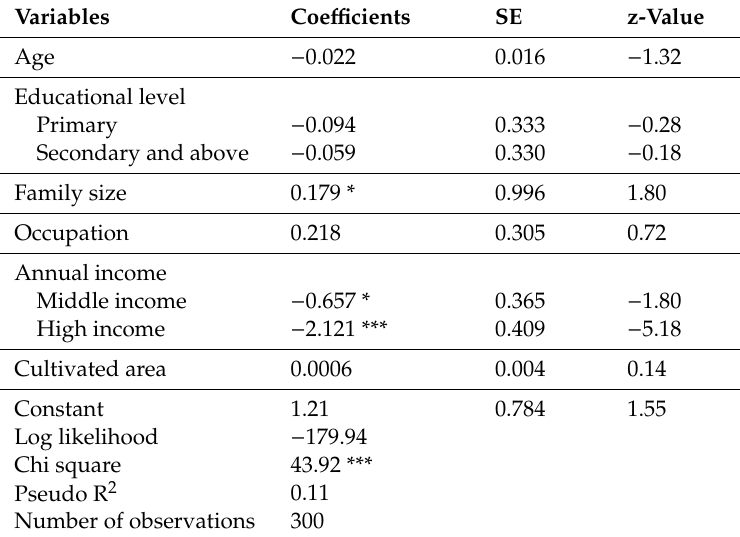
Table 5. Factors a ff ecting the accessibility of microcredit: logit